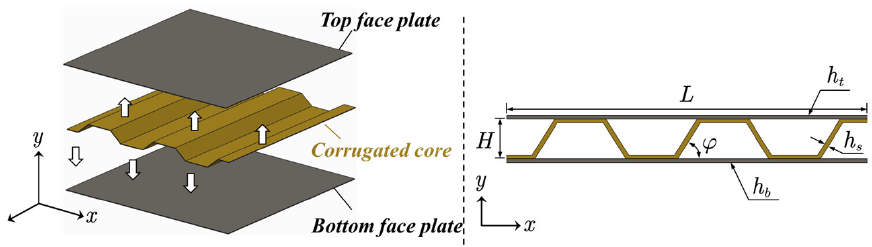
Figure 14. The calculation time and relative error (with respect to the present method) of conven- tional FEM.